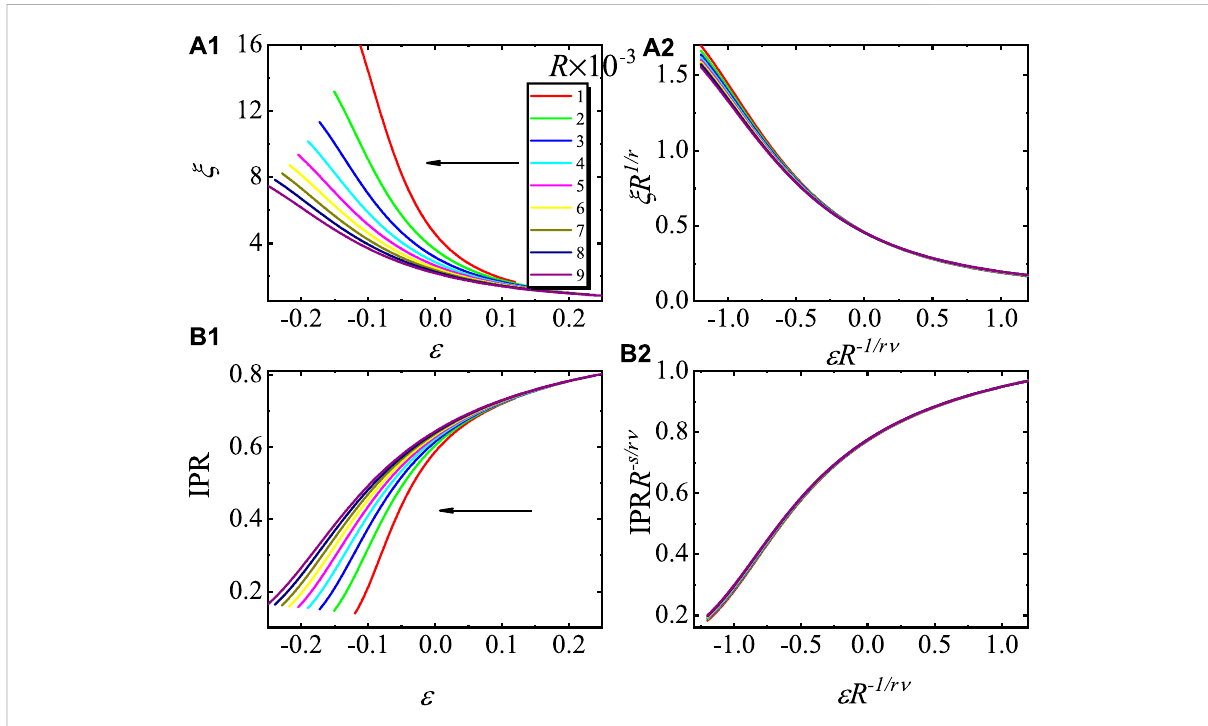
FIGURE 6 Driven dynamics with the initial ground state at ε = 1. (A1) Curves of ξ versus ε and (A2) the rescaled curves according to Eq. 10 for different R values.(B1)CurvesoftheIPR n versus ε and(B2)therescaled curvesaccordingtoEq.11fordifferent R values.Here,weuse ε 0 =1, g =0.5,and L =987, and the results are averaged for 10 choices of ϕ . The arrows in (a1) and (b1) point to the direction of the changing ε